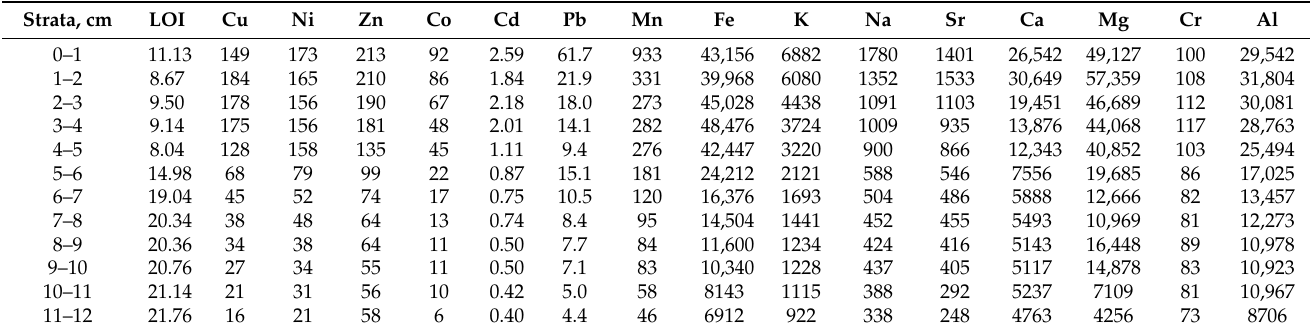
Table 6. Metal concentrations (mg/kg, dry weight) and weight loss on ignition (%) in the column of bottom sediments of Lake Kovdor.